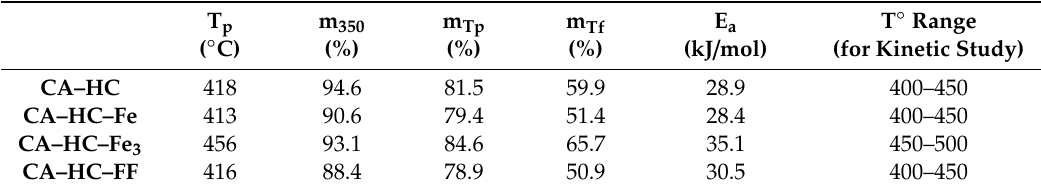
Table 2. TGA main peak temperature (T p , ◦ C), representative mass loss values (%) at 350 ◦ C (m 350 ), and characteristic kinetic parameters.